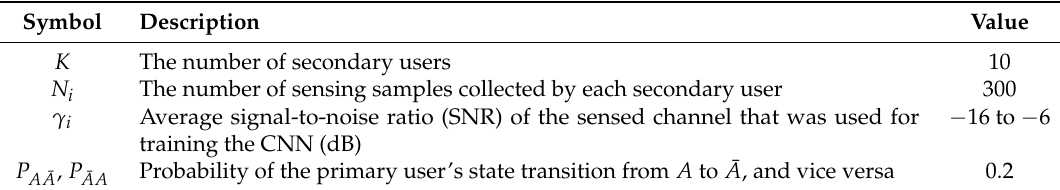
Table 2. Simulation parameters for the convolutional neural network (CNN) -based cooperative spectrum sensing (CBCSS)